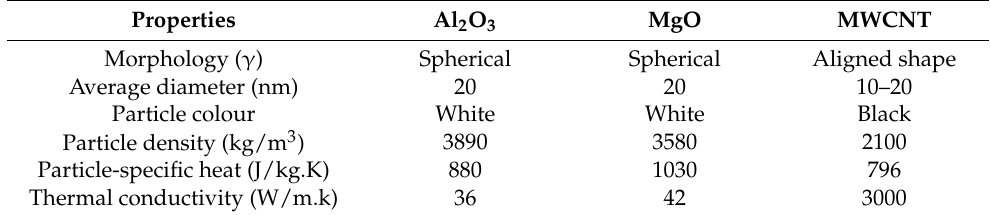
Table 3. Nanoparticle properties [61].